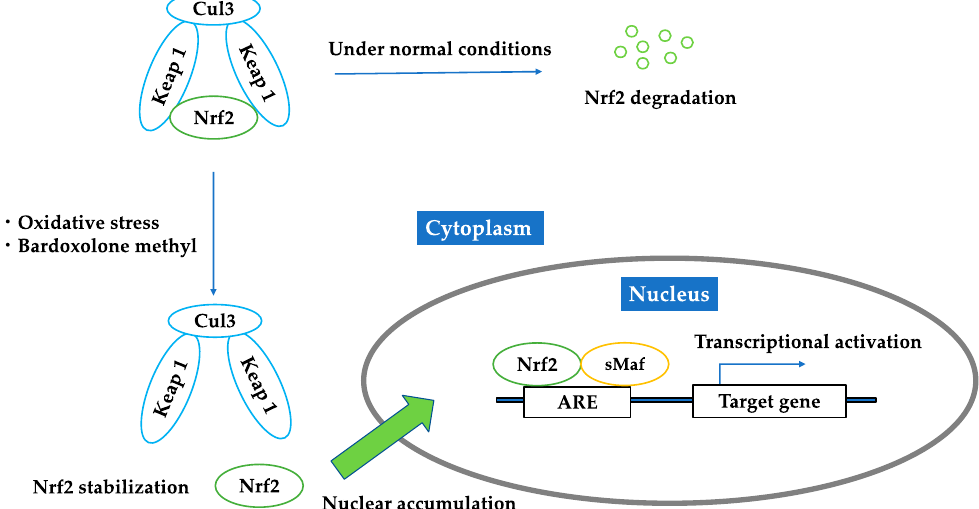
Figure 1. Regulation of Nrf2 under unstressed condition; oxidative stress; bardoxolone methyl. Under normal conditions, Nrf2 is kept in the cytoplasm and continuously degraded by Keap1. Under oxidative stress conditions or the existence of bardoxolone methyl, Nrf2 is released from Keap1. The released Nrf2 translocates into the nucleus, forms heterodimers with other transcription factors, such as small Maf proteins, and binds to the antioxidant response elements and activates downstream genes.